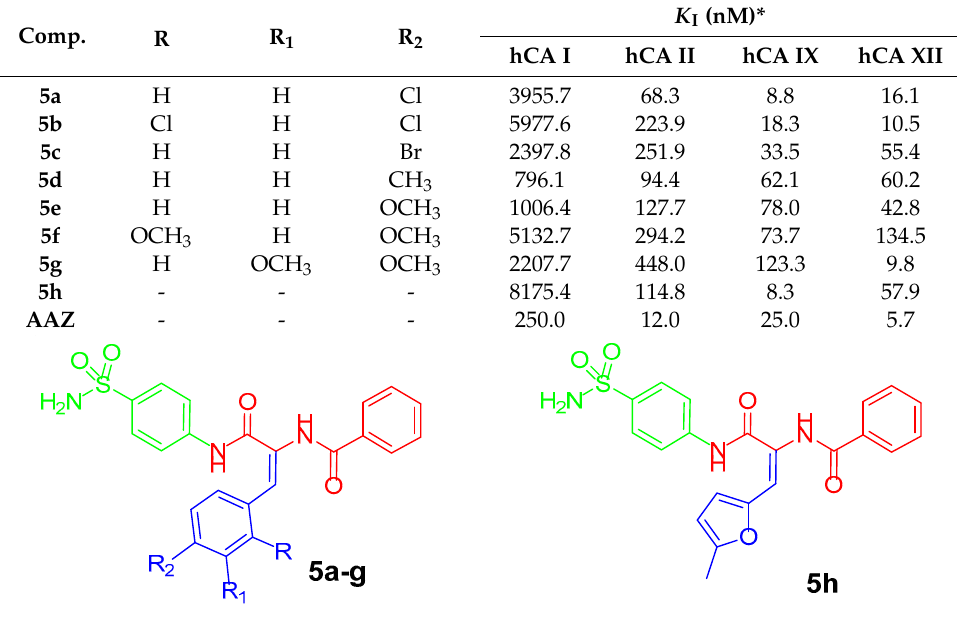
Table 1. Inhibition data of human CA isoforms hCA I, II, IX and XII for diamide-based benzenesulfonamides 5a–h, determined by stopped-flow CO 2 hydrase assay, using acetazolamide (AAZ) as a standard drug. Comp.